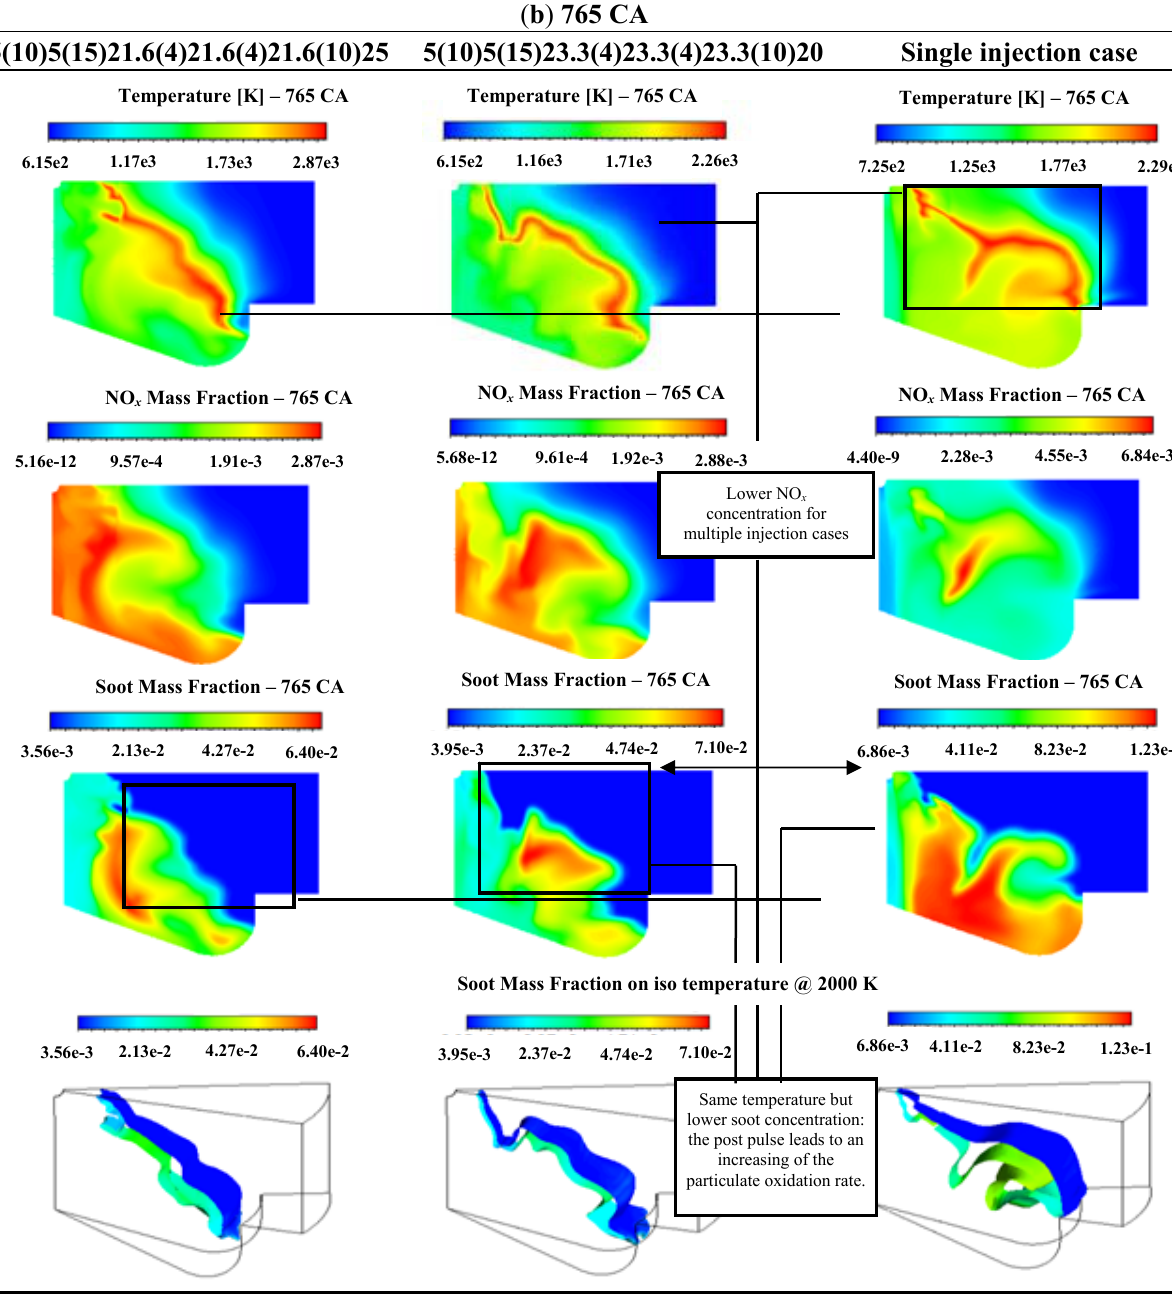
5(10)5(15)21.6(4)21.6(4)21.6(10)25 5(10)5(15)23.3(4)23.3(4)23.3(10)20 Single injection